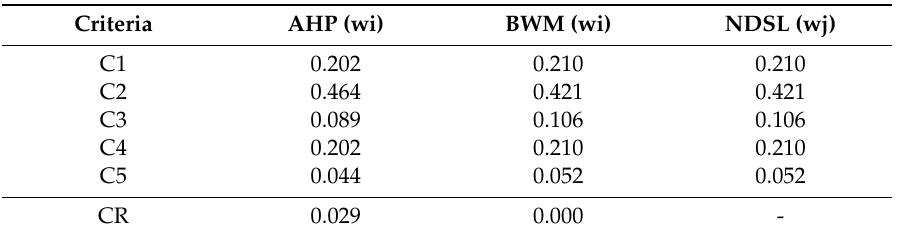
Table 2. A comparative presentation of the results obtained by applying the NDSL, Best Worst Method (BWM), and AHP